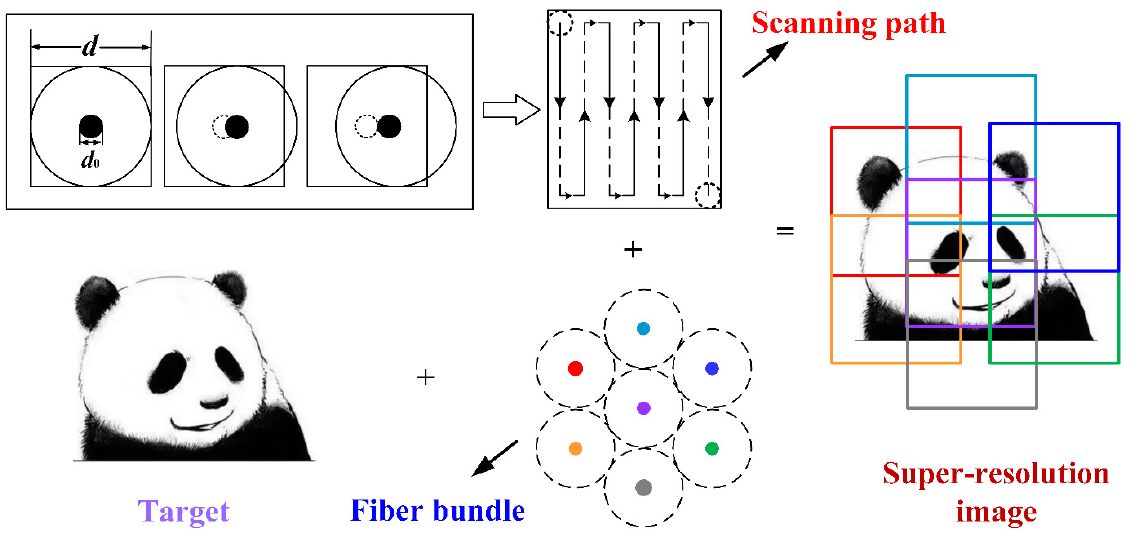
Figure 1. Schematic of high-resolution imaging based on optical fiber bundle combined with micro-scanning.